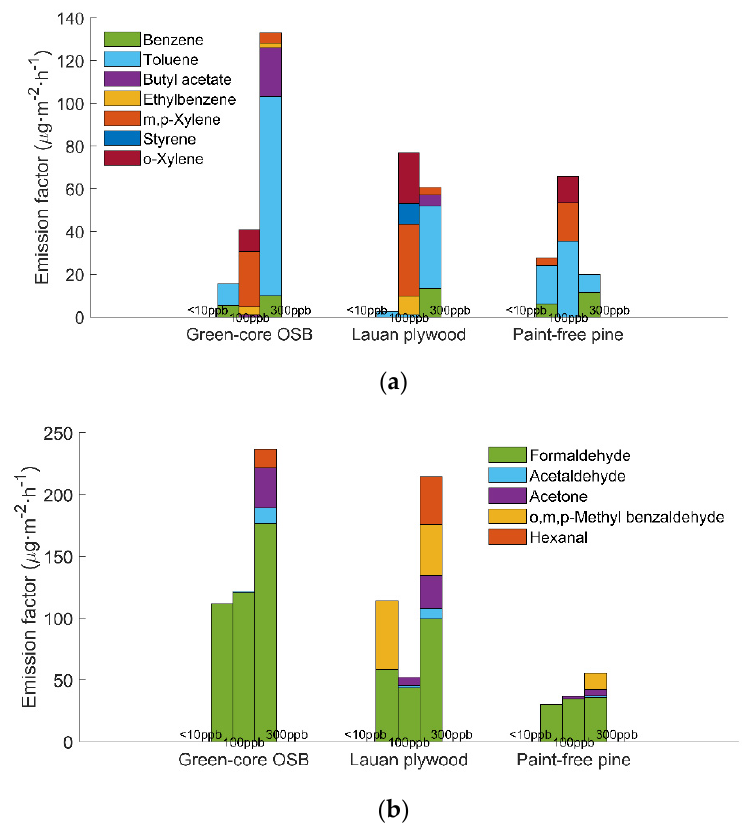
Figure 5. Primary and secondary emissions between ozone and wood-based panels. ( a ) Aromatics, esters, and aliphatic compounds. ( b ) Aldehydes and ketones.